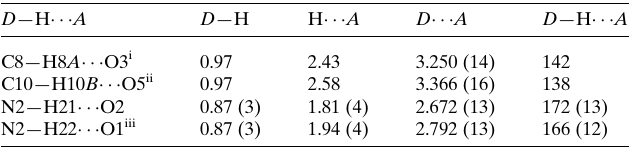
Table 6 Hydrogen-bond geometry (A˚ , (cid:5) ) for 7 .